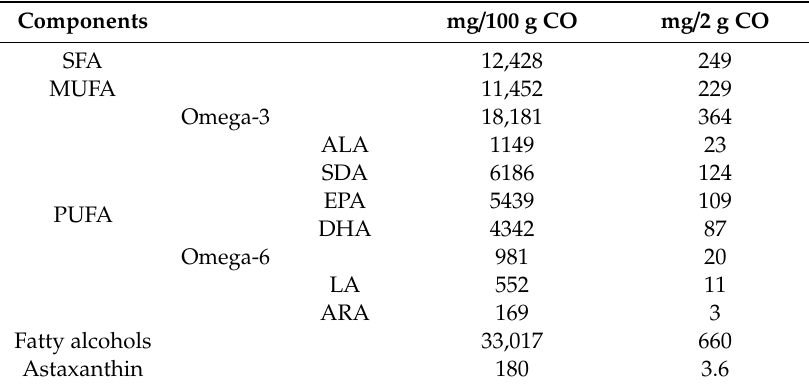
Table 1. Composition of oil from Calanus finmarchicus